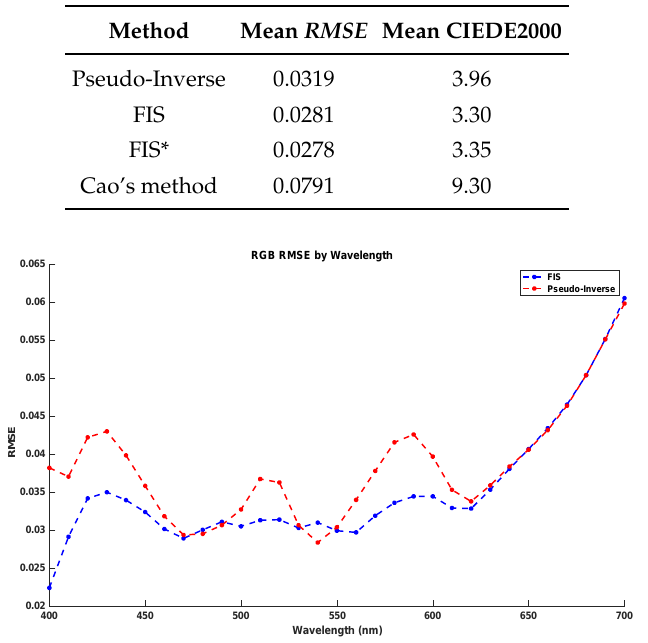
Figure 14. RMSE local error by wavelength comparative between Pseudo-Inverse and FIS using the testing